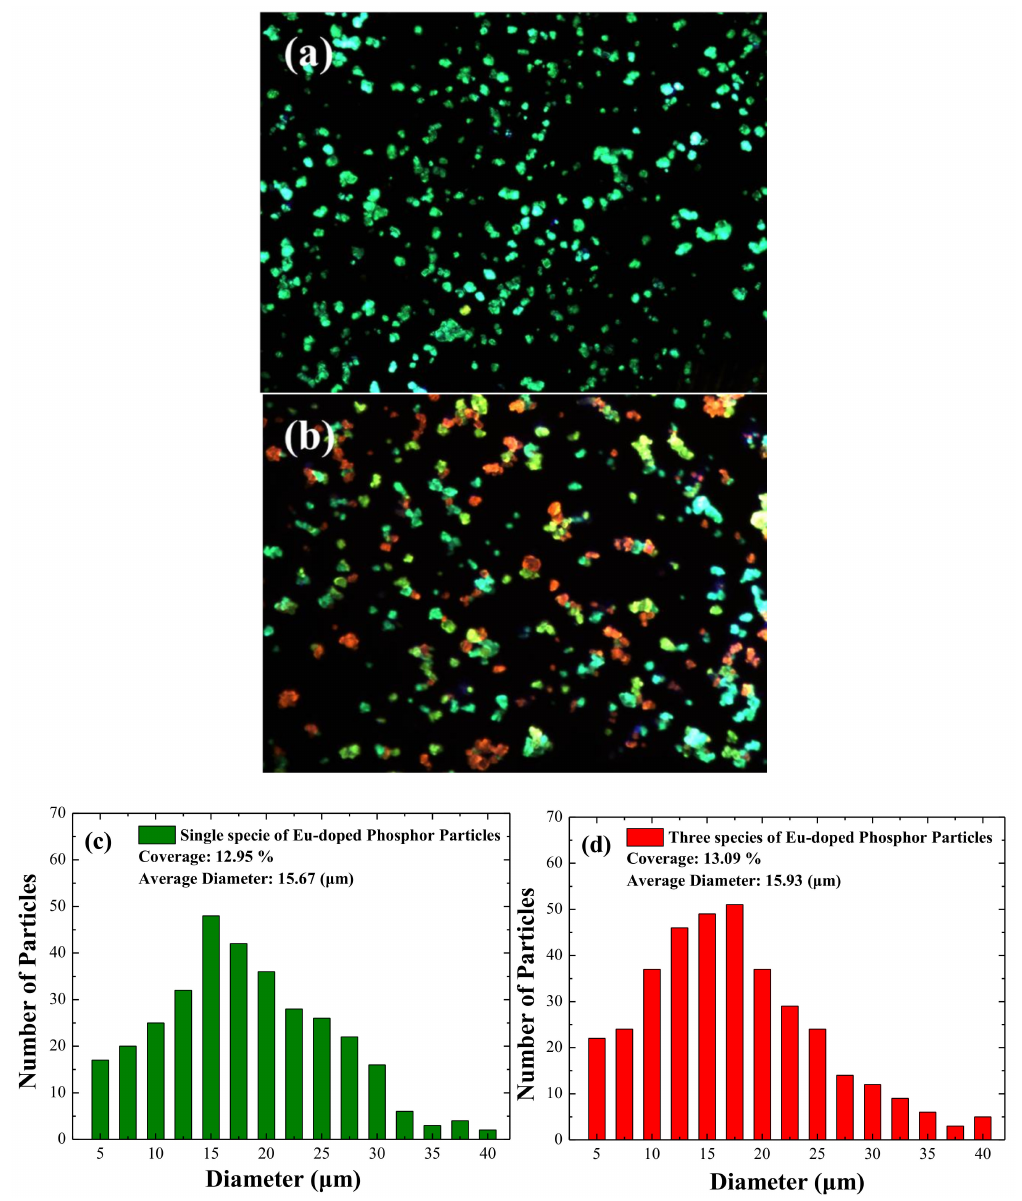
Figure 4. Optical microscope images (100 × ) of LDS layer with ( a ) single species (specie-A); ( b ) combination of specie-A/specie-B/specie-C; ( c , d ) size distribution and coverage of phosphor particles respectively calculated using Image-J software from images in Figure